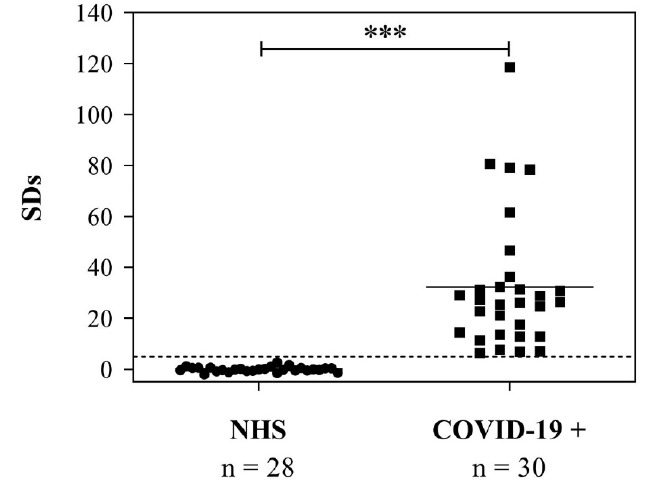
Figure 8. Immunoreactivity of rRBD produced in Sf9 cell line by b-ELISA. SARS-CoV-2 antibody test results obtained by b-ELISA from pre-pandemic samples (n = 28) and samples obtained from seropositive COVID-19 patients (n = 30). Results are expressed as SDs. The cut-off value (SDs > 5.0) is indicated by a dotted line and medians for each population are indicated as a full line (*** p < 0.0001, statistically significant). NHS: normal human sera. COVID-19+: seropositive COVID-19 pa- tients.